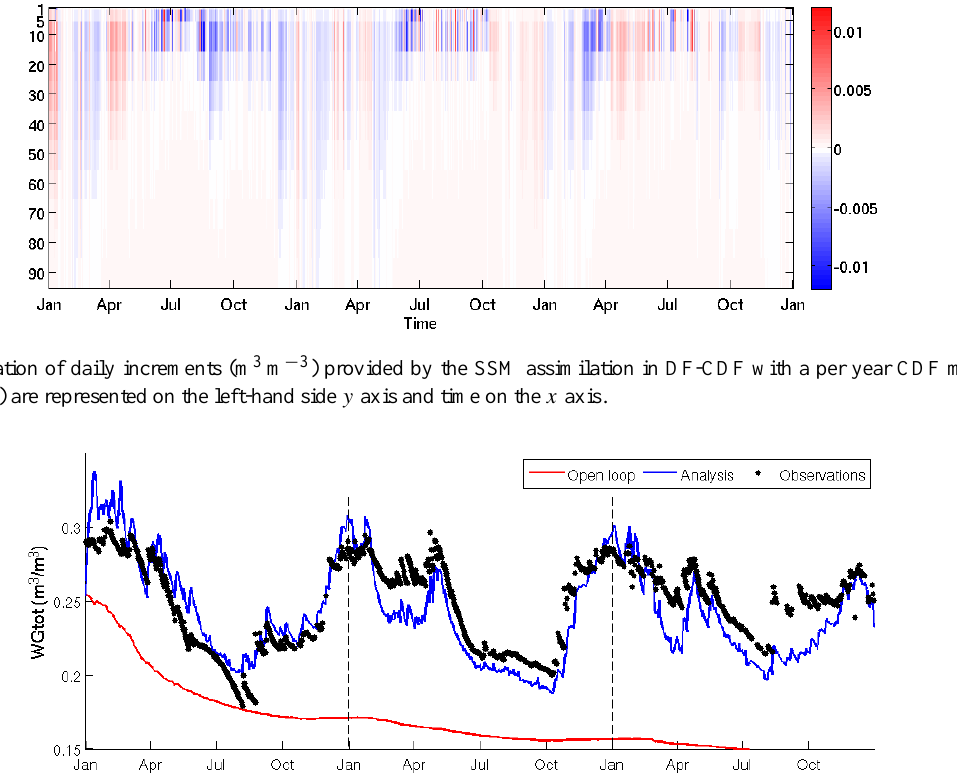
40 Fig. 14. Time series of root zone soil moisture observations (black dots), soil moisture open-loop simulation (red lines) and soil moisture analysis simulation (blue lines) computed with the experiment DF-NP.